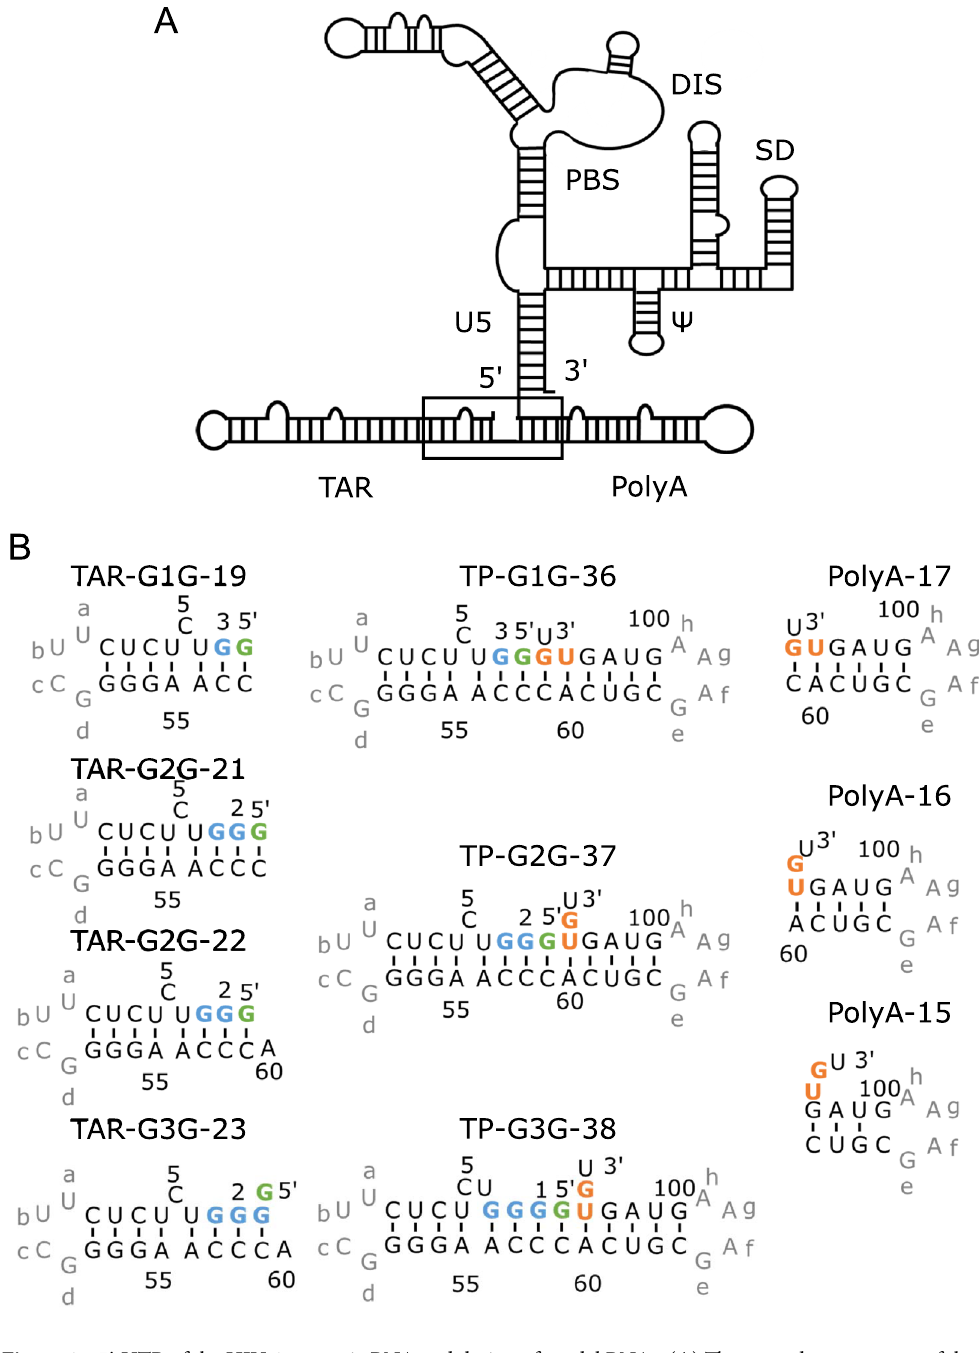
Figure 1. 5 ′ -UTR of the HIV-1 genomic RNA and design of model RNAs. ( A ) The secondary structure of the 5 ′ -UTR was shown. The target of the present work is the region including the TAR and PolyA stems as indicated by a box. ( B ) The designed RNAs for the junction region are shown in the middle column. G1G, G2G and G3G were each fragmented around a junction of TAR-PolyA and both ends were capped by tetraloops; for TAR and PolyA, the UUCG and GAAA loops were added, respectively. These constructed residues were indicated by grey. The designed fragments were called TP-G1G-36, TP-G2G-37, and TP-G3G-38 according to the number of residues. Furthermore, these RNAs were divided into TAR and PolyA fragments, as shown in the left and right columns, so that possible base pairs remained for each fragment. TP-G1G-36 was divided into TAR-G1G-19 and PolyA-17. TP-G2G-37 was divided into TAR-G2G-21 and PolyA-16, or TAR-G2G-22 and PolyA-15. TP-G3G-38 was divided into TAR-G3G-23 and PolyA-15. The residue number starts with the first G residue of the three transcription start sites. The G residues corresponding to the three transcription start sites and 5 ′ -Cap are coloured light blue and green, respectively. U104 and G105 at the 3 ′ -end of the PolyA stem were coloured